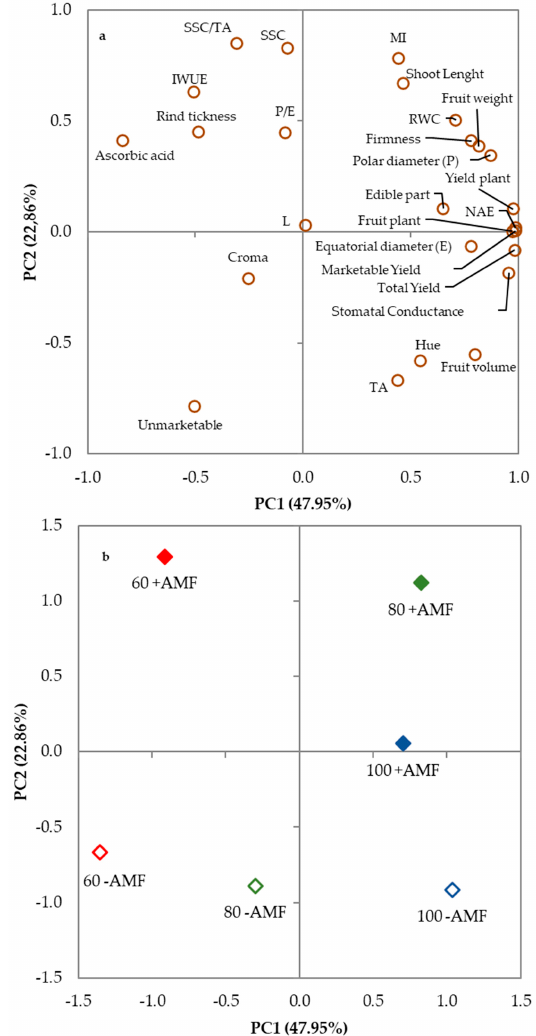
Figure 12. Plot of ( a ) loadings (morphophysiological parameters, yield components, and fruit characteristics of melon, and ( b ) scores (trials) formed by the two principal components from the Principal Component Analysis (PCA). 60: irrigation with 60% ETc (red color); 80: irrigation with 80% ETc (green color); 100: irrigation with 100% ETc (blue color); +AMF: plants inoculated with arbuscular mycorrhizal fungi (full symbol); − AMF: plants not inoculated with arbuscular mycorrhizal fungi (empty